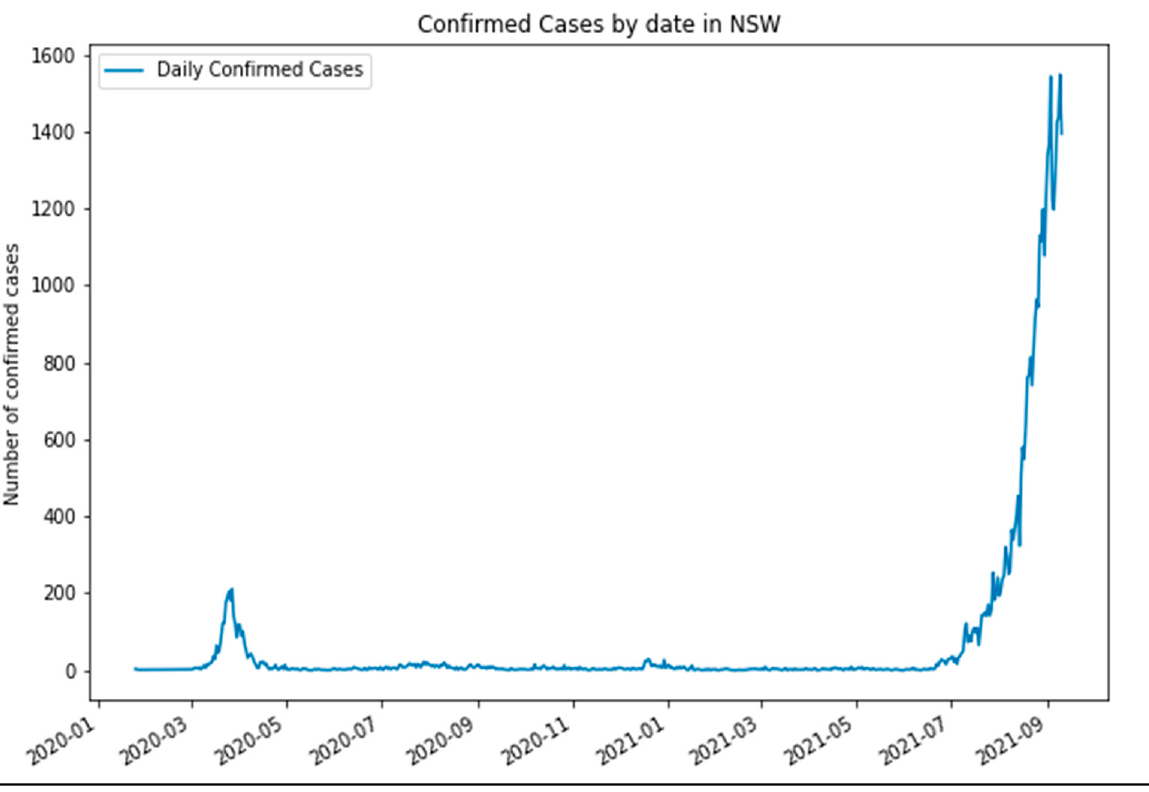
Figure 1. Confirmed COVID-19 cases from January 2020 to August 2021.